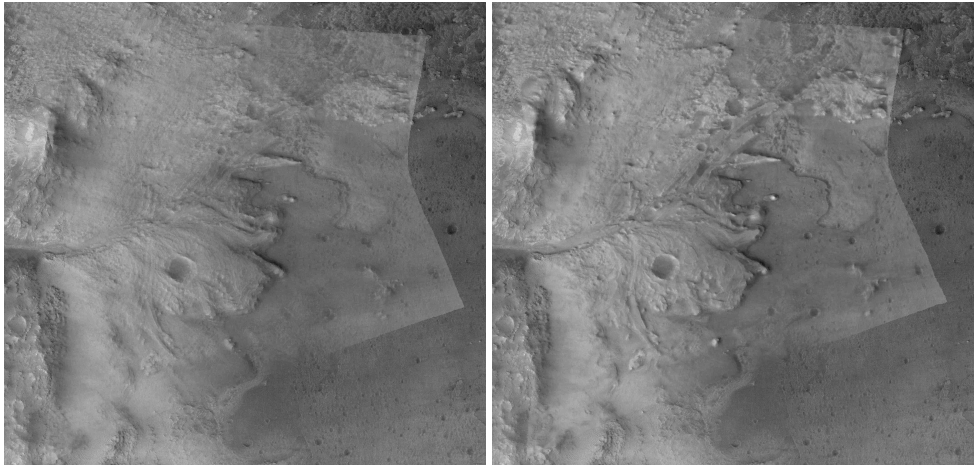
Figure A1. A 592 nm channel of CRISM observation FRT00005C5E overlaid on top of CTX P06_003442_1987_XI_18N282W before coregistration ( left ) and after coregistration ( right